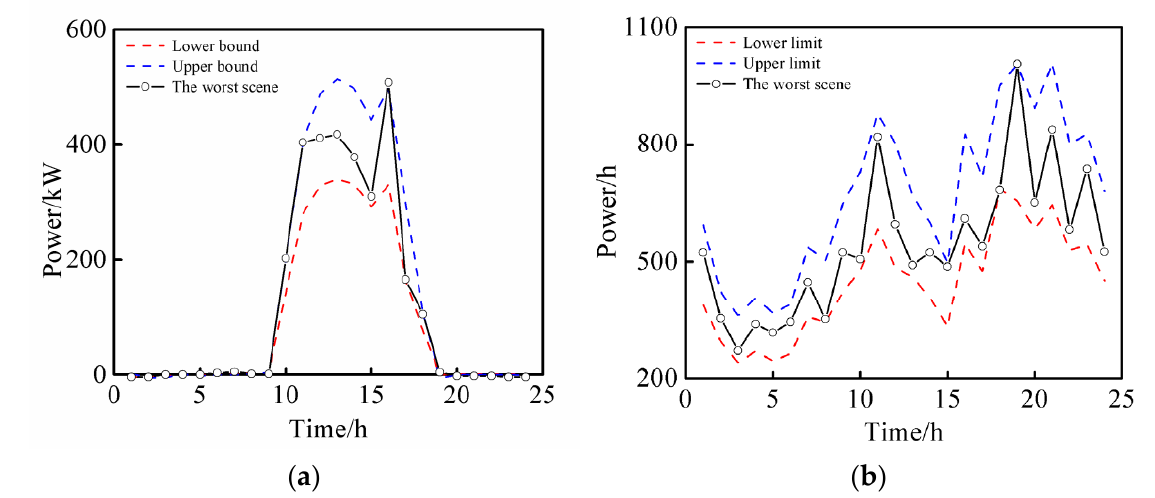
Figure 9. Balance diagram of Subsystem 3 under Scenario 4. ( a ) Electricity balance. ( b ) Gas balance.